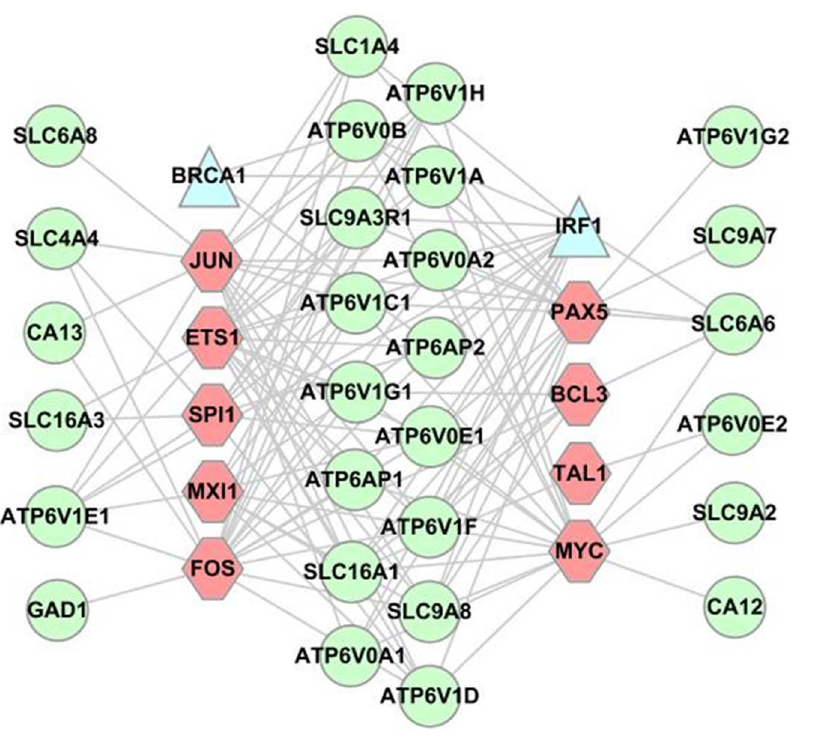
Figure 4. Regulatory relationships between genes involved in deacidification and cancer growth. Each circle represents a deacidification-related gene, each hexgon represents an oncogene and each triangle a tumor suppressor gene, with each link representing a direct regulatory relationship.